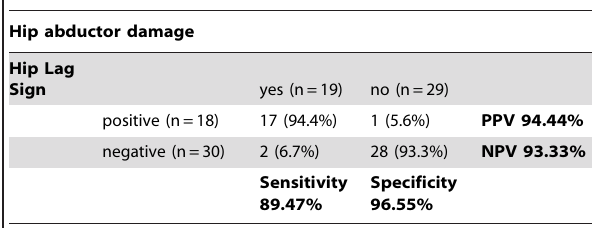
Table 2. Shown is the 2 6 2-table to execute calculations for sensitivity, specificity, as well as positive and negative predictive value.